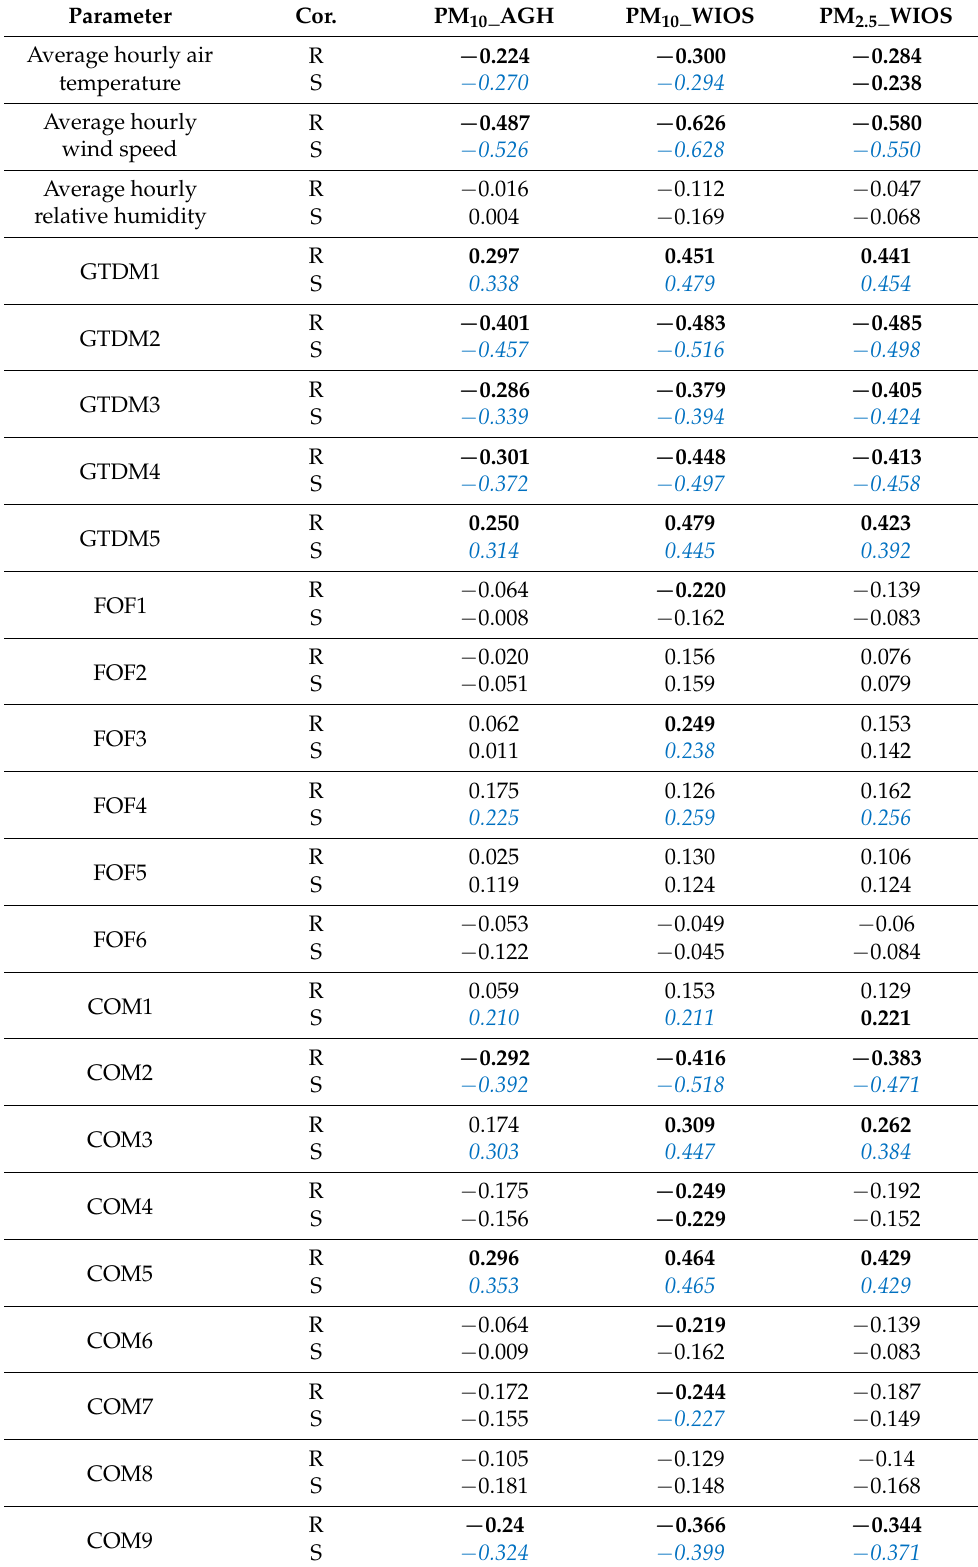
Table 2. Pearson’s (R) and Spearman (S) correlation coefficients between PM 10 and PM 2.5 texture parameters and weather data. Statistically significant correlations with p ≤ 0.005 are marked in